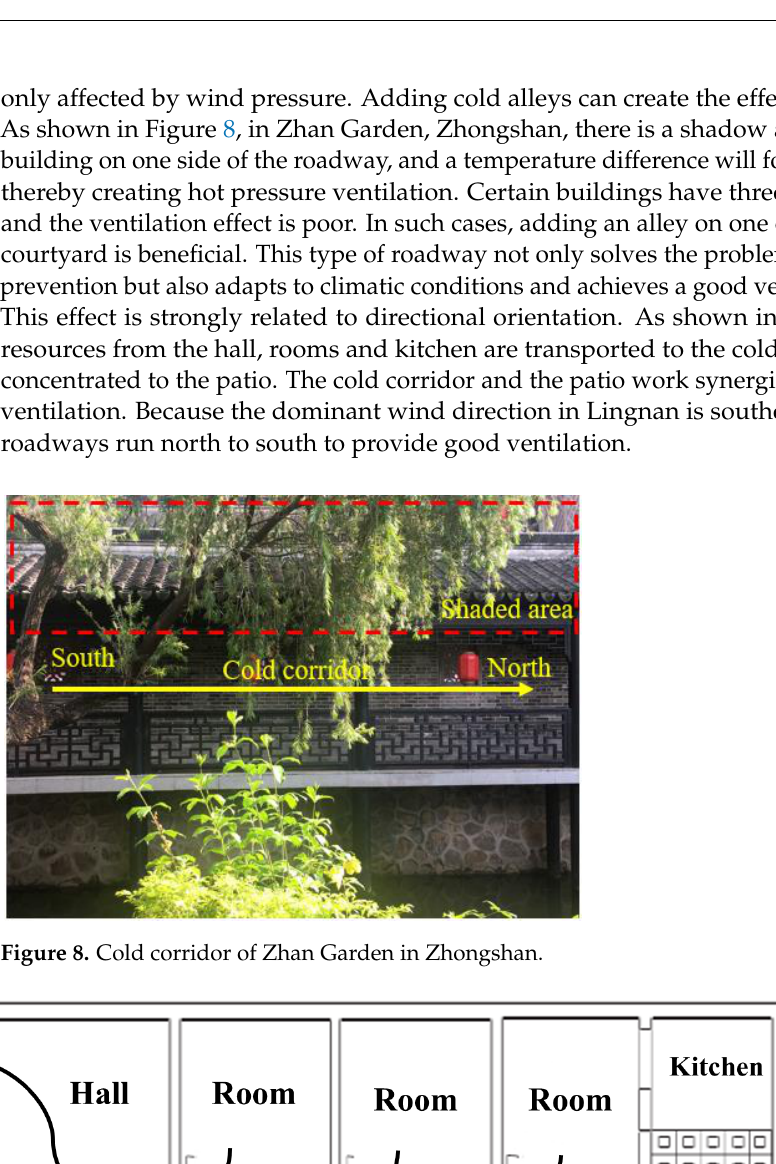
( c ) Figure 10. Doors and windows of traditional buildings in Guangdong. 4. Architectural Art of Traditional Guangdong Buildings 4.1. Hakka Traditional Buildings The Hakka people who moved to Guangdong gathered at the junction of North Mountain and South Mountain. Their survival and development were based on adhering to their original cultural characteristics while integrating the advantages of the local in- digenous culture into their living customs, language, totem worship, residential buildings and into other material and spiritual aspects of their culture. As one of the districts with the most prominent Hakka ethnic features, the Meizhou area is rich in typical traditional cultural elements of Hakka [18]. The Dragon House, as shown in Figure 11, which exhibits the regional characteristics of the Hakka building, is the most popular architectural style among the Hakka buildings in northern Guangdong. The distribution of the Dragon House is centred on the Hakka-inhabited hinterland in Xingning, Meixian, Guangdong. It